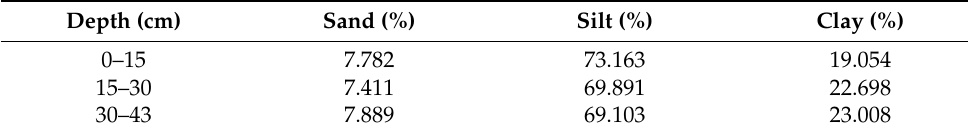
Table 4. The seafloor